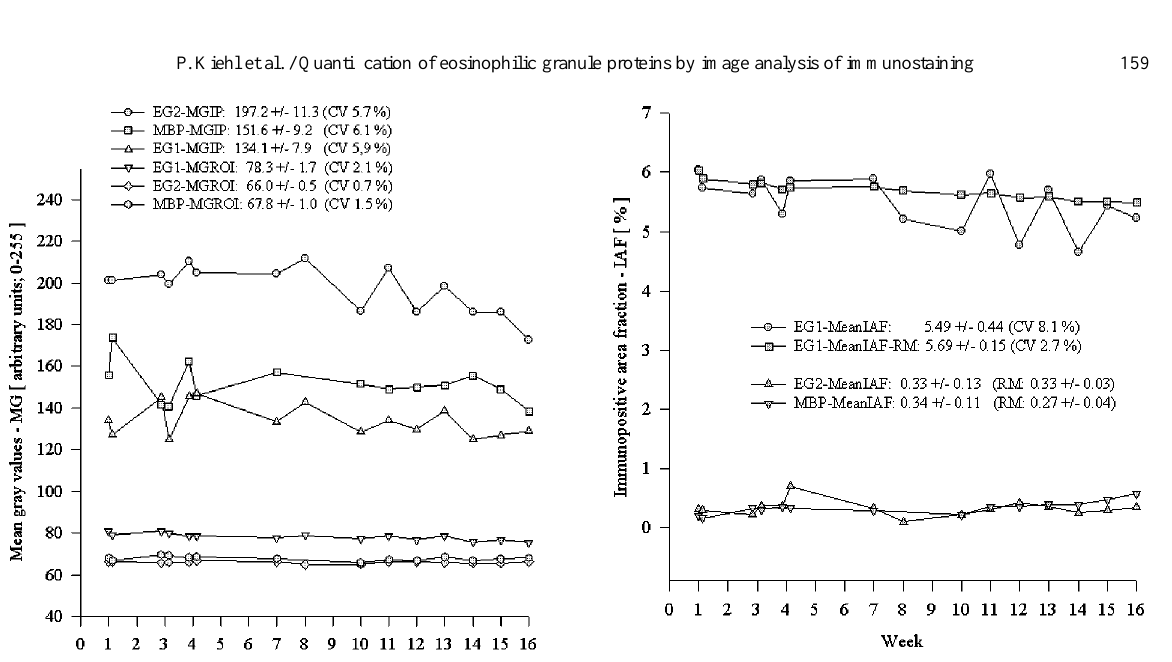
Fig. 4. VARTOTAL-IAF: Mean immunopositive area fraction (MeanIAF) in 44 sequential sections immunostained with the anti- bodies EG1 ( n = 15), EG2 ( n = 15) or MBP ( n = 14) within a 16-weeks period. (Values in the legend: Mean of all measurements (cid:6) SD; CV = coefficient of variation; RM = running